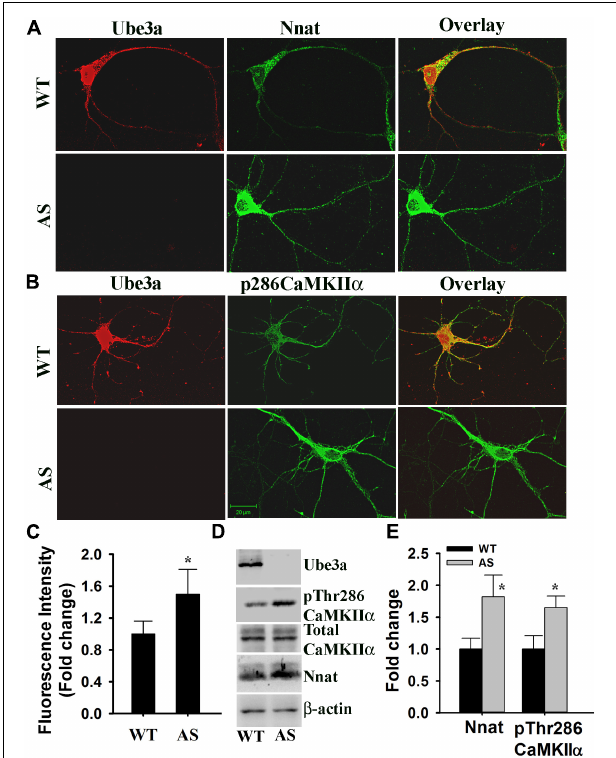
FIGURE 7 | Primary cultured cortical neurons (E16 + 14DIV) prepared from AS mice embryos demonstrate increased expression of Nnat along with higher basal intracellular Ca 2 + and increased phosphorylation of CaMKII α at Thr286. (A) Double immunofluorescence staining of Nnat and Ube3a in the cortical neuron prepared from wild type and AS embryos. (B) Double immunofluorescence staining of pThr286 CaMKII α and Ube3a showing increased phosphorylation of CaMKII α at Thr286 in the cortical neuron cultured from AS mice embryo. At least 20 immunostained neurons from three different embryos in each group were assessed and most Ube3a-deficient neurons showed increased level of Nnat and pCaMKII α at Thr286. (C) Comparison of intracellular basal Ca 2 + level in the primary cortical neuron (E16 + 14 DIV) obtained from wild type and AS embryos using Fluo-4 AM dye. About 50–60 cells prepared from three different embryos in each group were used for evaluation. (D,E) Immunoblot analysis of Ube3a, Nnat and total and Thr286 phosphorylated form of CaMKII α in the lysate prepared from primary cultured cortical neurons. Nnat level was normalized against β -actin while pThr286CaMKII α was normalized against total CaMKII α . Values are mean ± SD of three independent experiments. ∗ P < 0.05 compared to respective wild type control